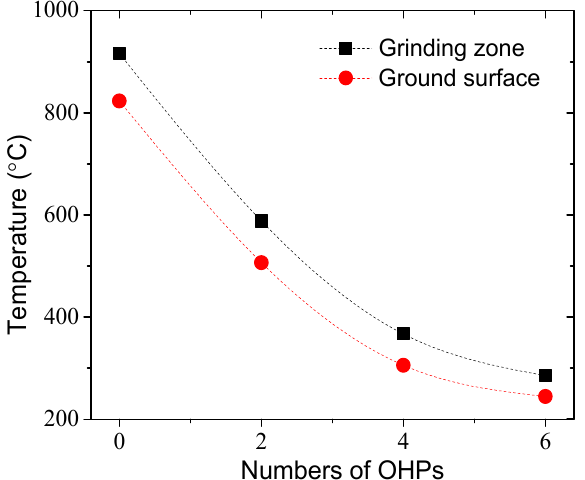
Figure 14. The highest temperature in the grinding zone and the ground surface temperature under a grinding heat flux of 10 7 W/m 2 .